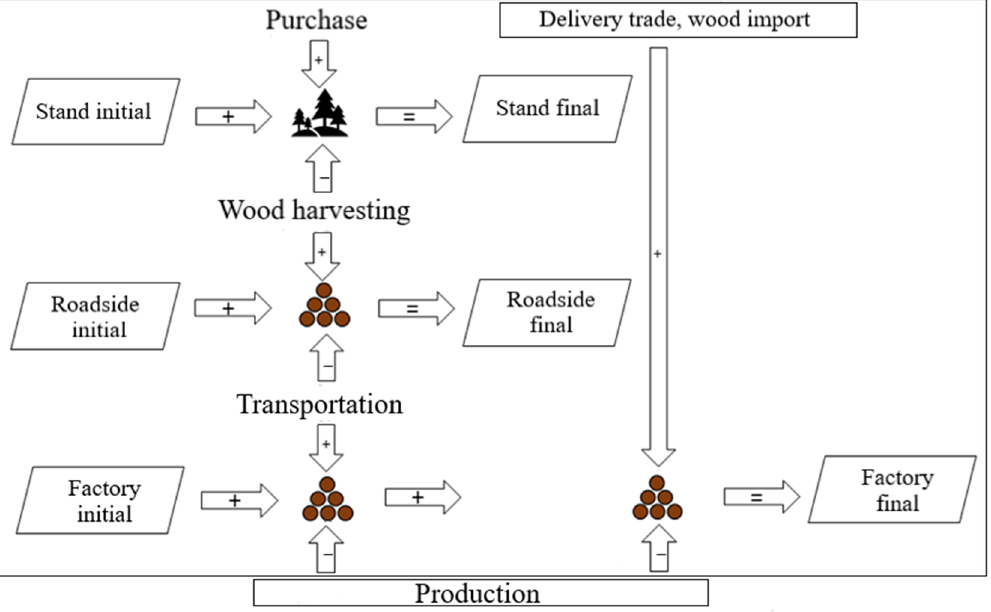
Figure 2. General system description of wood supply and procurement dynamics of continuous wood flow, including wood import as the delivery trade with collaborating forest industry companies. The sequence of operations is described by vertical arrows, and the effects of time on the inventories by horizontal arrows in the rectangular area.